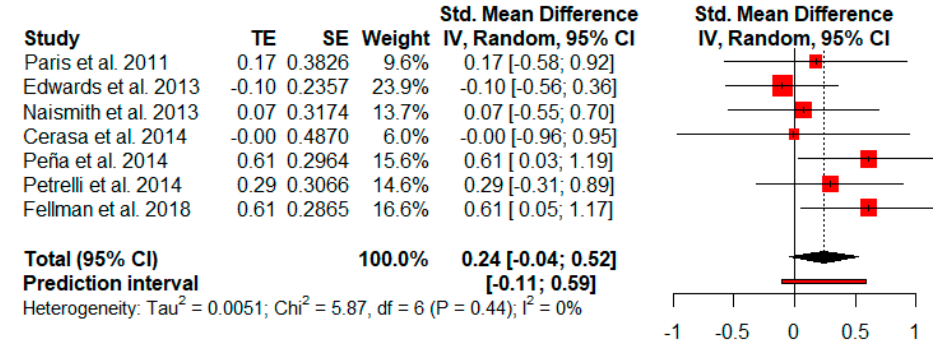
Figure 12. Effectiveness of cognitive rehabilitation in depressive symptoms. Figure 12 . Effectiveness of cognitive rehabilitation in depressive symptoms.